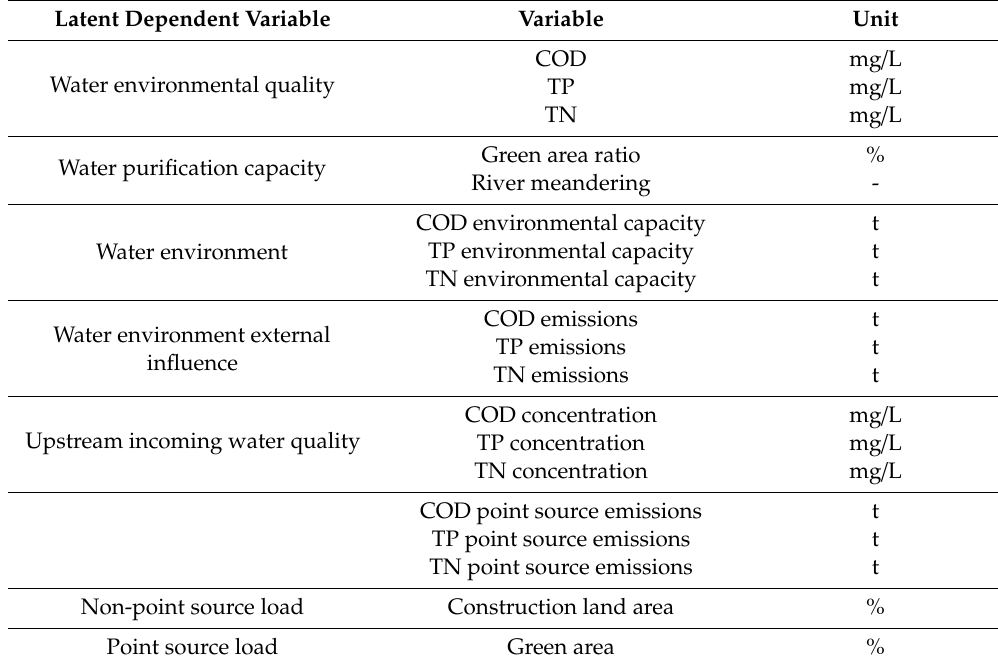
Table 3. Structural equation model (SEM) measurement variables and potential variables.